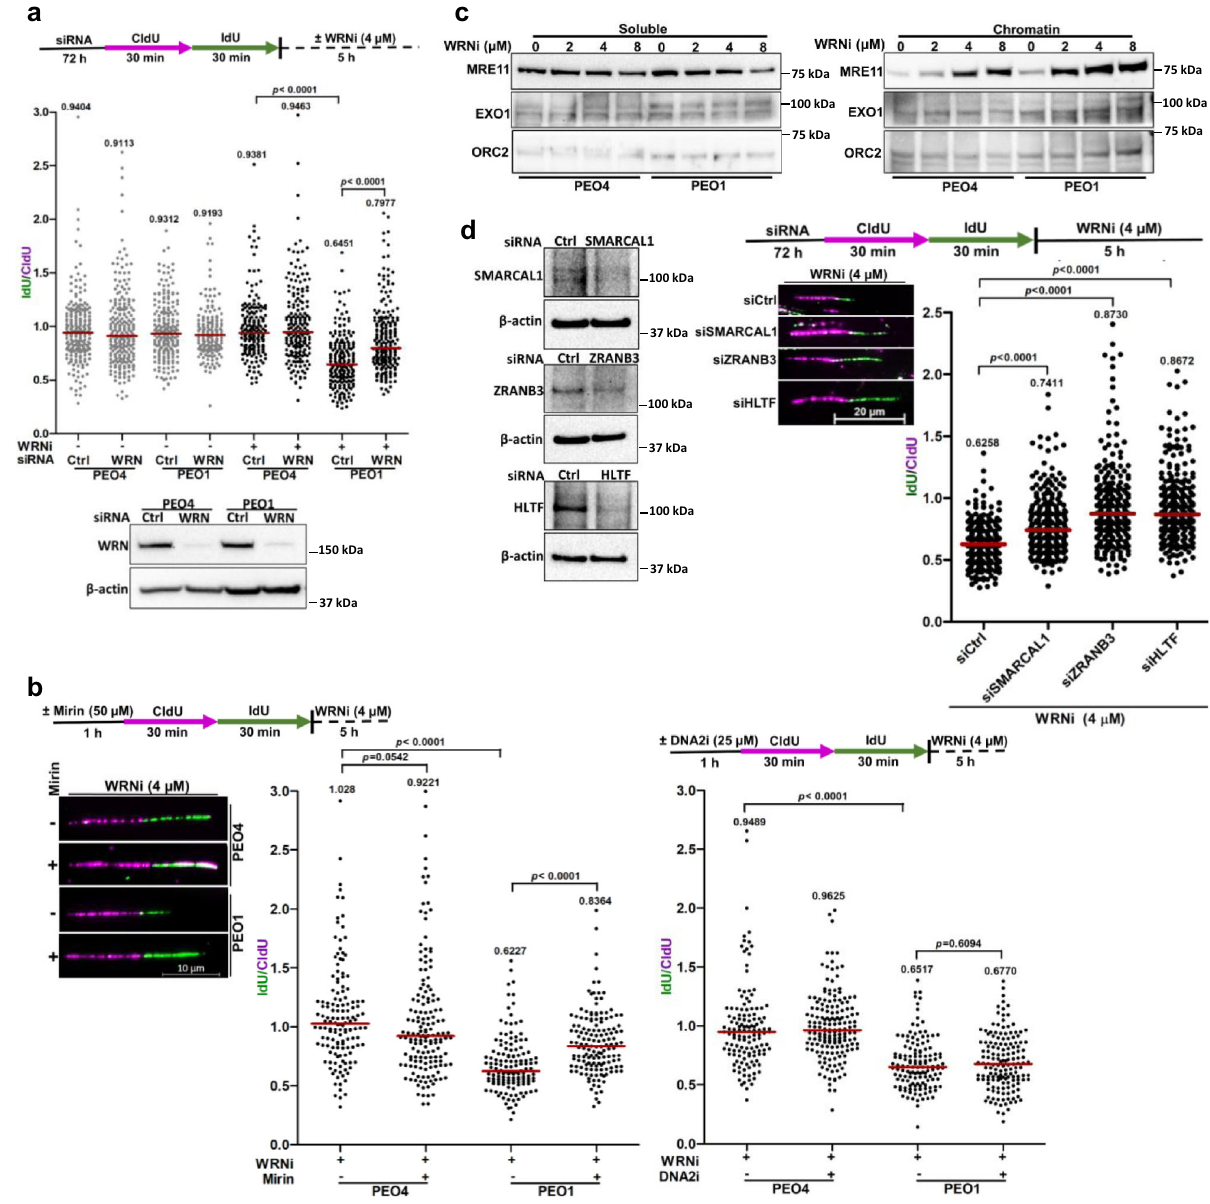
Fig. 3 WRN helicase inhibition triggers SNF2 translocase-dependent nascent DNA degradation by MRE11 nuclease in BRCA2 -mutated cancer cells. a Fork stability assay in PEO1 and PEO4 cells exposed to WRNi NSC617145. Cells transfected with either control or WRN siRNA (80 nM) were sequentially labeled with CldU and IdU and subjected to WRNi (NSC617145) treatment (4 µ M) for 5 h. For untreated control, cells were collected immediately after labeling. Scatter plot showing IdU/CldU tract length ratios in individual experimental conditions. Representative of n = 2 independent experiments; p -values ( p < 0.0001, p < 0.0001) were derived from n ≥ 150 DNA fi bers usi n g two-tailed Mann – Whitney test. Immunoblots showing WRN knockdown. b Fork stability assay in NSC617145-treated PEO1 and PEO4 cells upon Mirin (left panel) or DNA2i (right panel) treatment. Representative fi bers of the Mirin experiment are shown. Representative of n = 2 independent experiments; p -values ( p = 0.0542, p < 0.0001, p < 0.0001, p < 0.0001, p = 0.6094) were derived from n ≥ 125 DNA fi bers using two-tailed Mann – Whitney test. c Immunoblots showing dose-dependent chromatin enrichment of MRE11 upon WRNi treatment. Cells were treated with indicated doses of WRNi (NSC617145) for 1 h and subjected to subcellular fractionation. EXO1 level is shown. ORC2 was used as a positive marker and loading control for chromatin fractions. d Fork stability assay in PEO1 cells depleted of SMARCAL1, ZRANB3, or HLTF upon NSC617145 treatment. (Left panel) Immunoblots showing knockdown. Representative DNA fi bers are shown. (Right panel) Quanti fi cation of IdU/CldU ratios in individual experimental conditions. Representative of n = 2 independent experiments; p -values ( p < 0.0001, p < 0.0001 , p < 0.0001) were derived from n ≥ 250 DNA fi bers using two-tailed Mann – Whitney test. In a , b , and d horizontal red bars indicate the median of IdU/CldU ratios; median IdU/CldU values are indicated; purple and green colors indicate CldU and IdU labeling, respectively. β -actin was used as a loading control in immunoblots in ( a ) and ( d ). Western blots a , c , d were repeated independently at least two times with similar results. Source data are provided as a Source Data fi